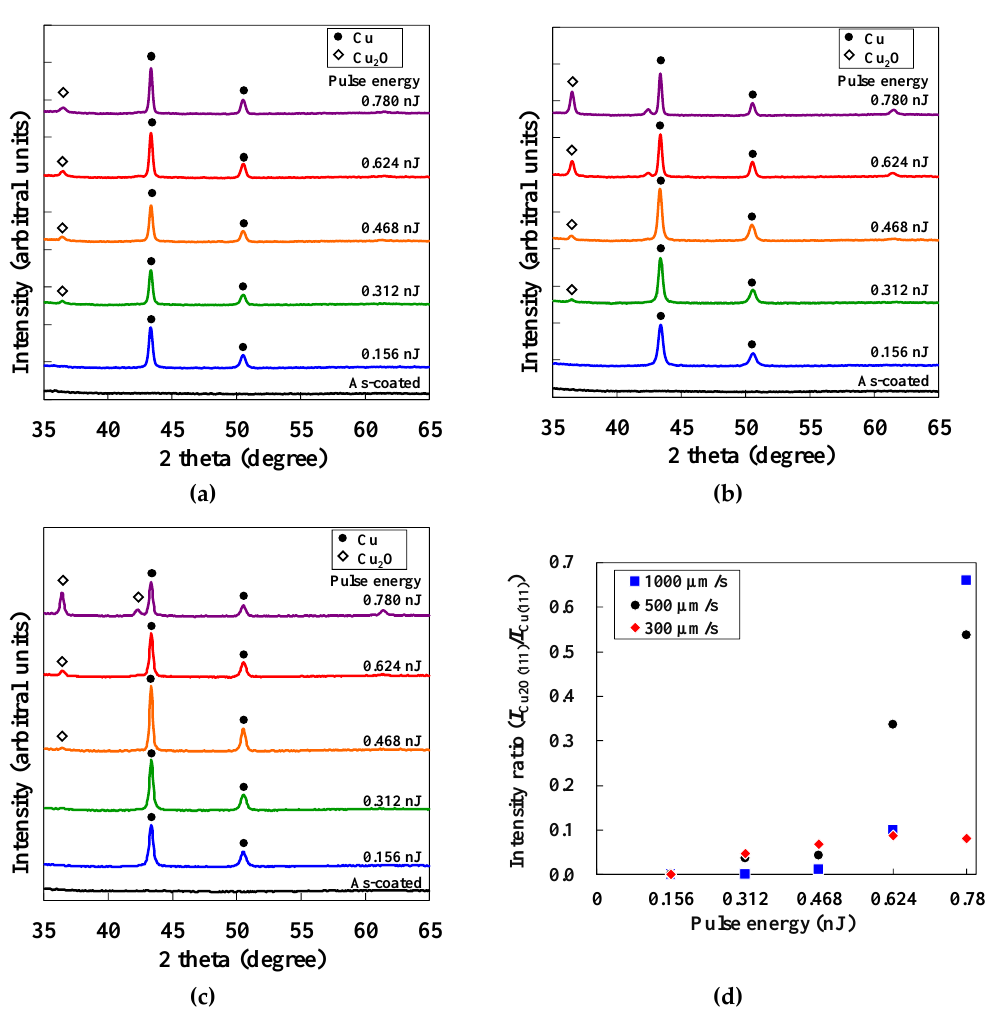
Figure 5. XRD spectra of fabricated micropatterns at a scanning speed of ( a ) 300 µm/s, ( b ) 500 µm/s, and ( c ) 1000 µm/s. ( d ) Intensity ratio of Cu 2 O to Cu as a function of pulse energy.